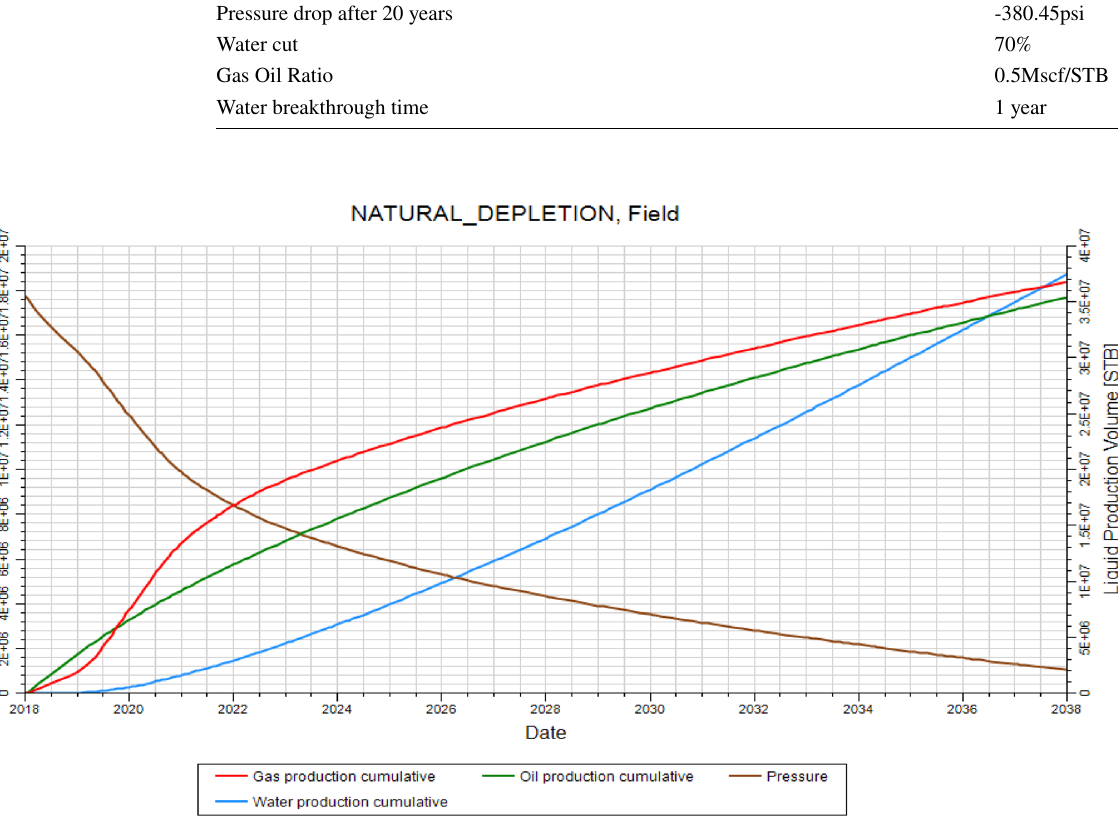
Table 2 Results from production prediction with natural depletion for 20 years